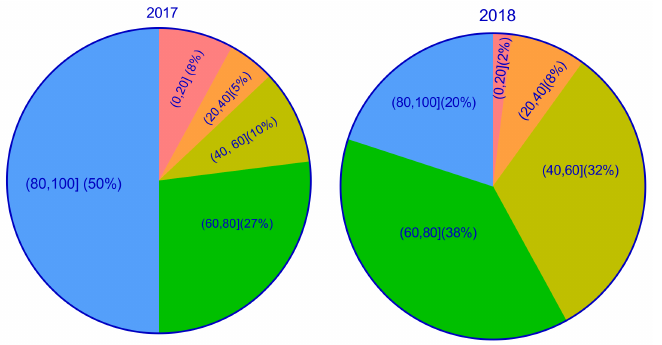
Figure 2. Emergence rate percentages in M 2 families.